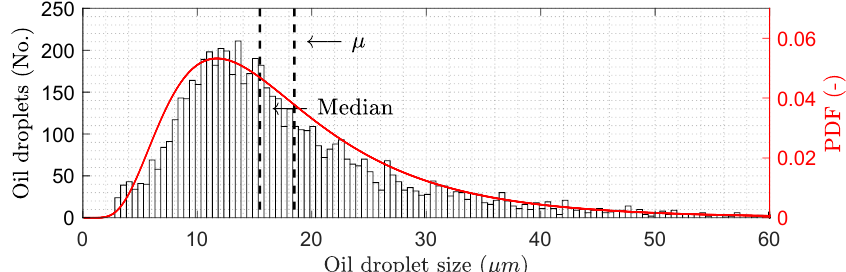
Figure 2. Droplet size distribution histogram based on measurements from the ViPA monitor with a mean and median of 18.47 µ m and 15.47 µ m, respectively [21].